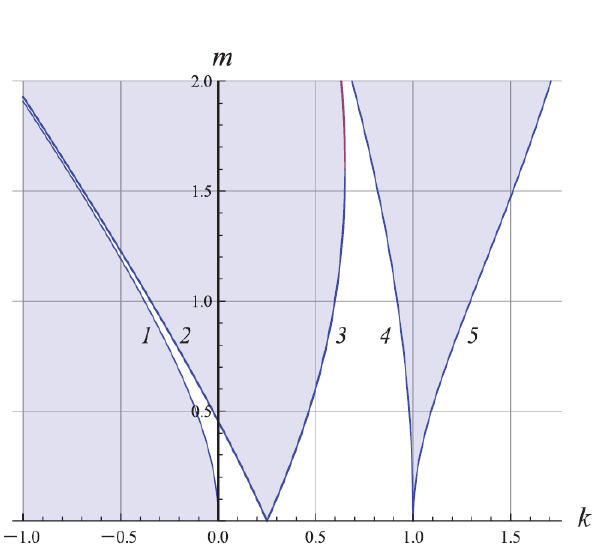
Figure 14. Results of the Mathieu equation, the Ince–Strutt diagram. The figure shows stable (white) and unstable (shaded) regions, depending on restoring term k and amplitude of the stability variation m . (Figure reproduced from Butikov [27]).